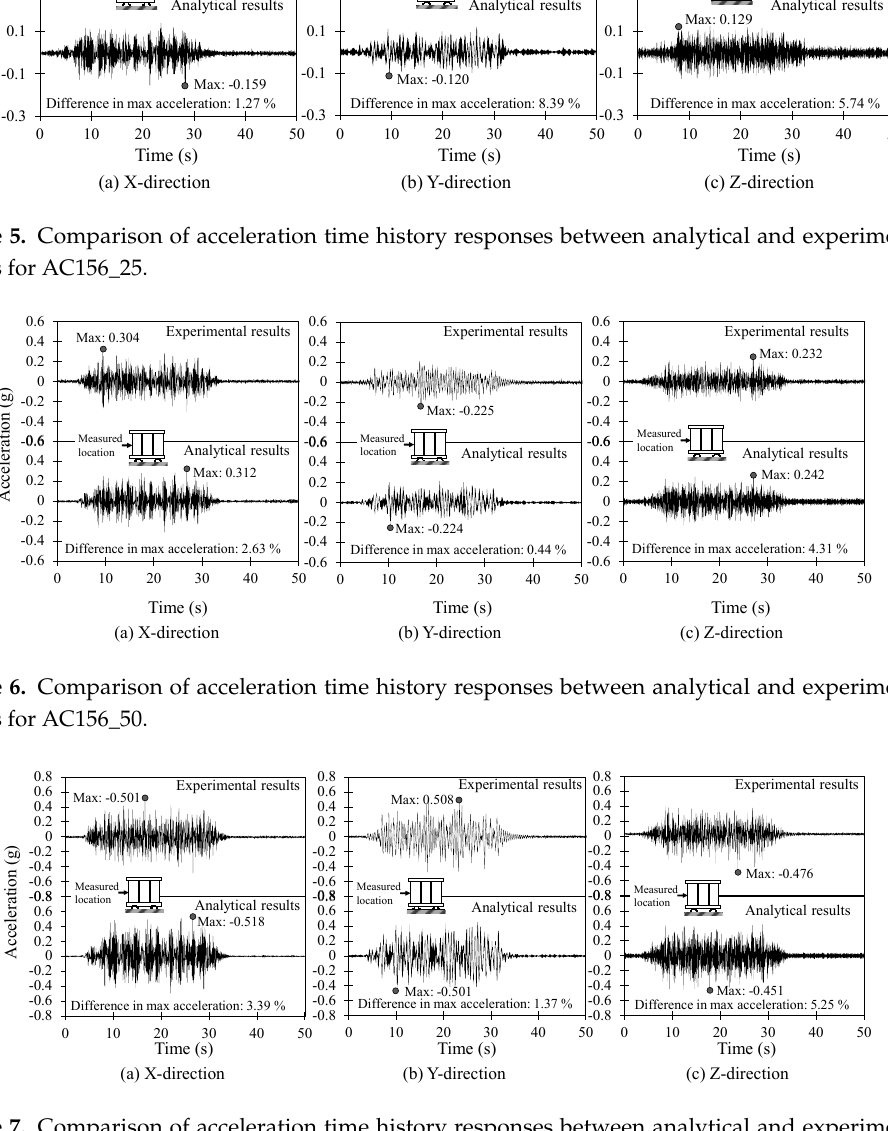
Figure 7. Comparison of acceleration time history responses between analytical and experimental results for AC156_100.